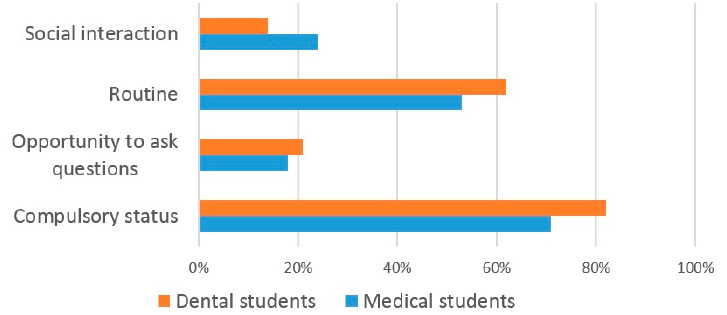
Figure 3. Medical student lecture self-reported attendance patterns before/after the introduction of VRL.